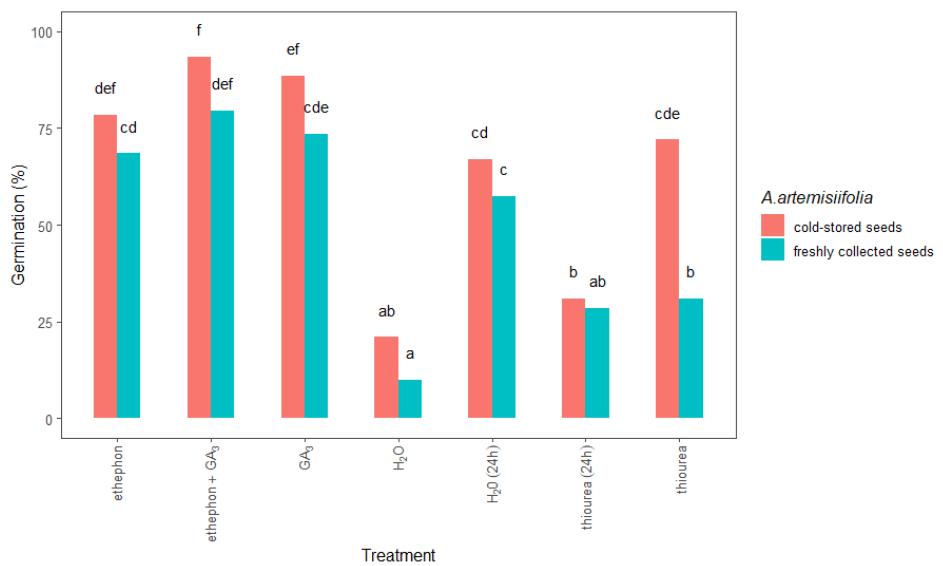
Figure 5. Total germination at 14 days after sowing freshly collected or cold-stored Ambrosia arte- misiifolia seeds that were conditioned in water or chemical solution. The estimated marginal means of eight replicates (standard error = 3.35) are shown. According to Tukey’s test, the means following the same letter are not significantly different ( p < 0.05). No germination was observed in seeds that were treated with thiourea + KNO 3 or GA 3 + thiourea + KNO 3 ; data not shown.